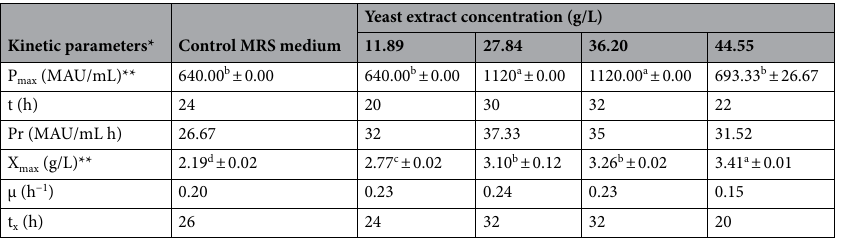
Table 1. Effects of different concentrations of yeast extract on the growth and antimicrobial activity of postbiotic RS5 produced by L. plantarum RS5. *P max (MAU/mL)—maximum antimicrobial activity, t (h)— cultivation time of maximum antimicrobial activity, Pr (MAU/mL h)—productivity of antimicrobial activity, X max (g/L)—maximum biomass, µ (h −1 )—specific growth rate, t x (h)—cultivation time of maximum biomass. **Values for P max (MAU/mL) and X max (g/L) are mean ± standard error of the mean (SEM), n = 3. Mean ± SEM within the same row that does not share a similar superscript are significantly different (p <